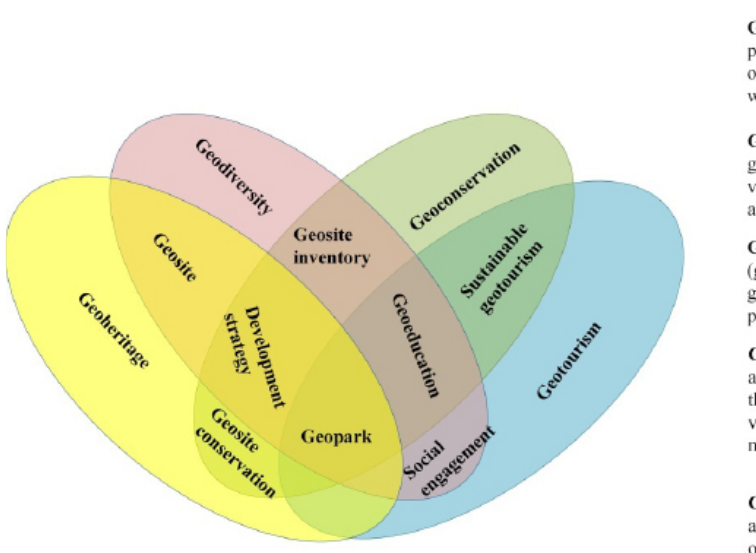
Figure 3 . Interrelations between geoheritage, geopark, geodiversity, geotourism and geoconservation. (After Williams et al.